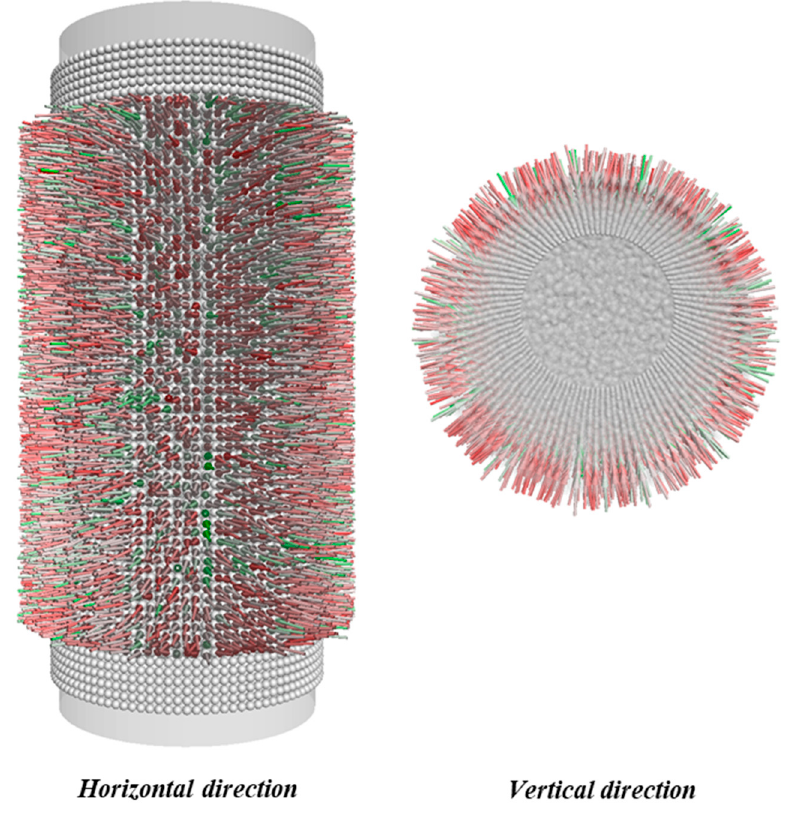
Figure 2. Results of confinement application.